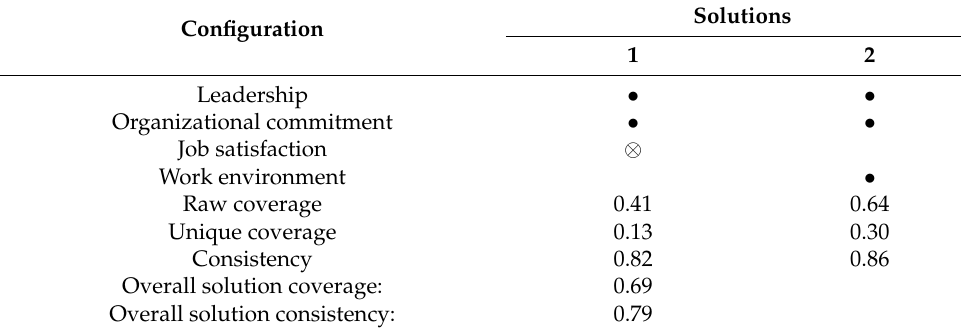
Table 5. Configurations for achieving a good job performance.